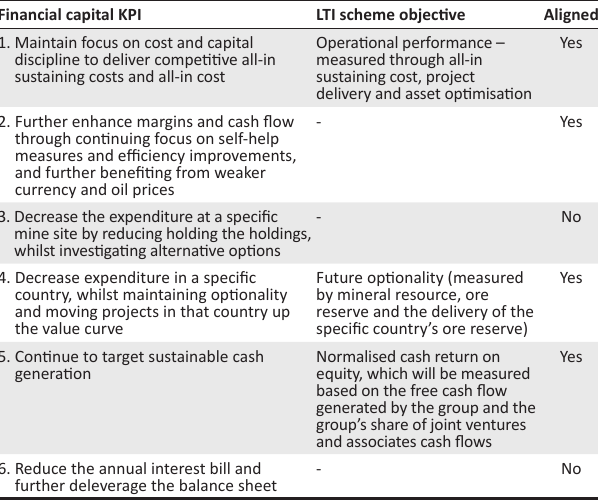
TABLE 3: Example of assessment of alignment between key performance indicators and long-term incentive scheme